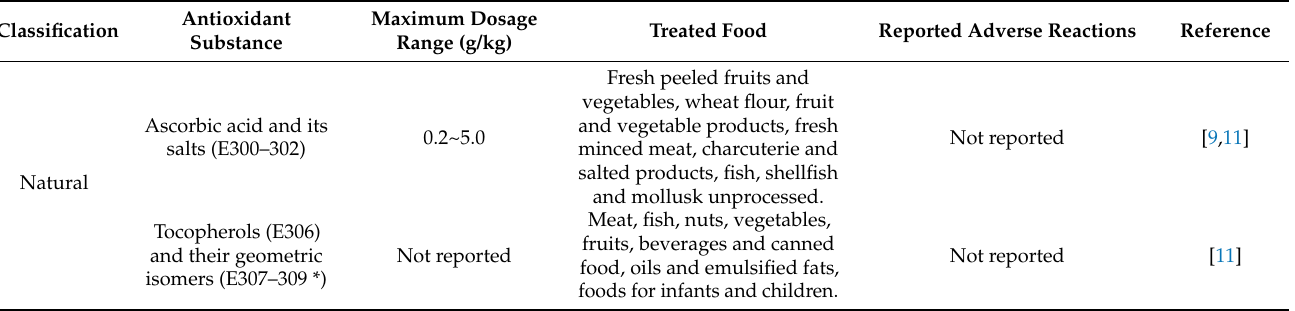
Table 1. E number, maximum dosage range, and reported adverse reactions of some antioxidants used in the food